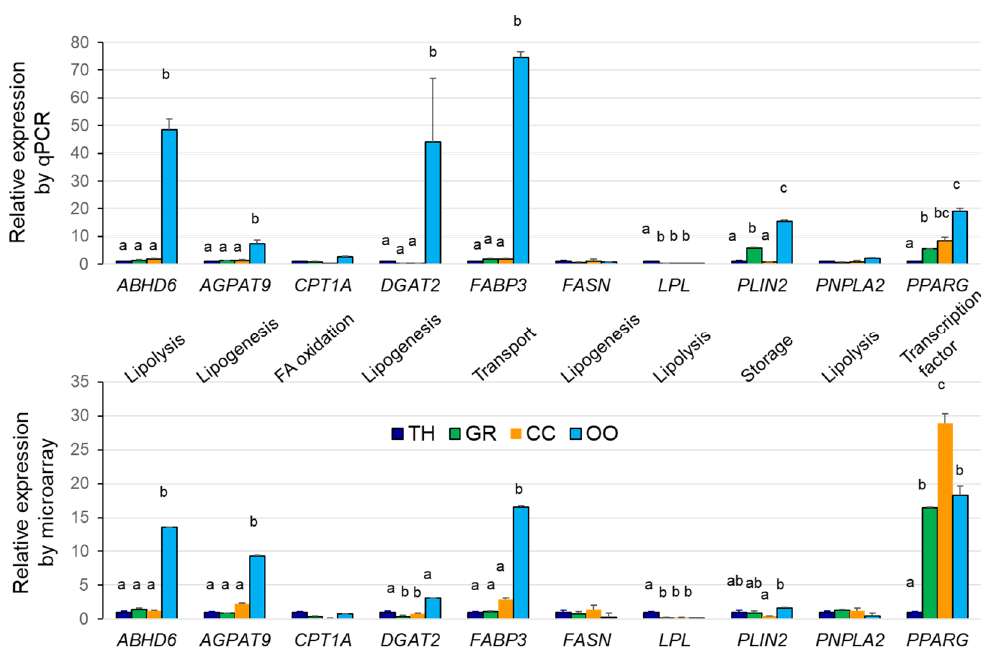
Figure 6. RT-qPCR validation of microarray gene expression analysis. Graphs are presented as the mean+/SEM of normalized expression values of several independent RNA samples per tissue ( n = 4 for microarray, and n = 6 for RT-qPCR analysis). Different letters indicate difference at p < 0.05 (ANOVA, Tukey post-hoc test). ABHD6 —Abhydrolase Domain Containing 6, AGPAT9 —1-Acyl-Sn-